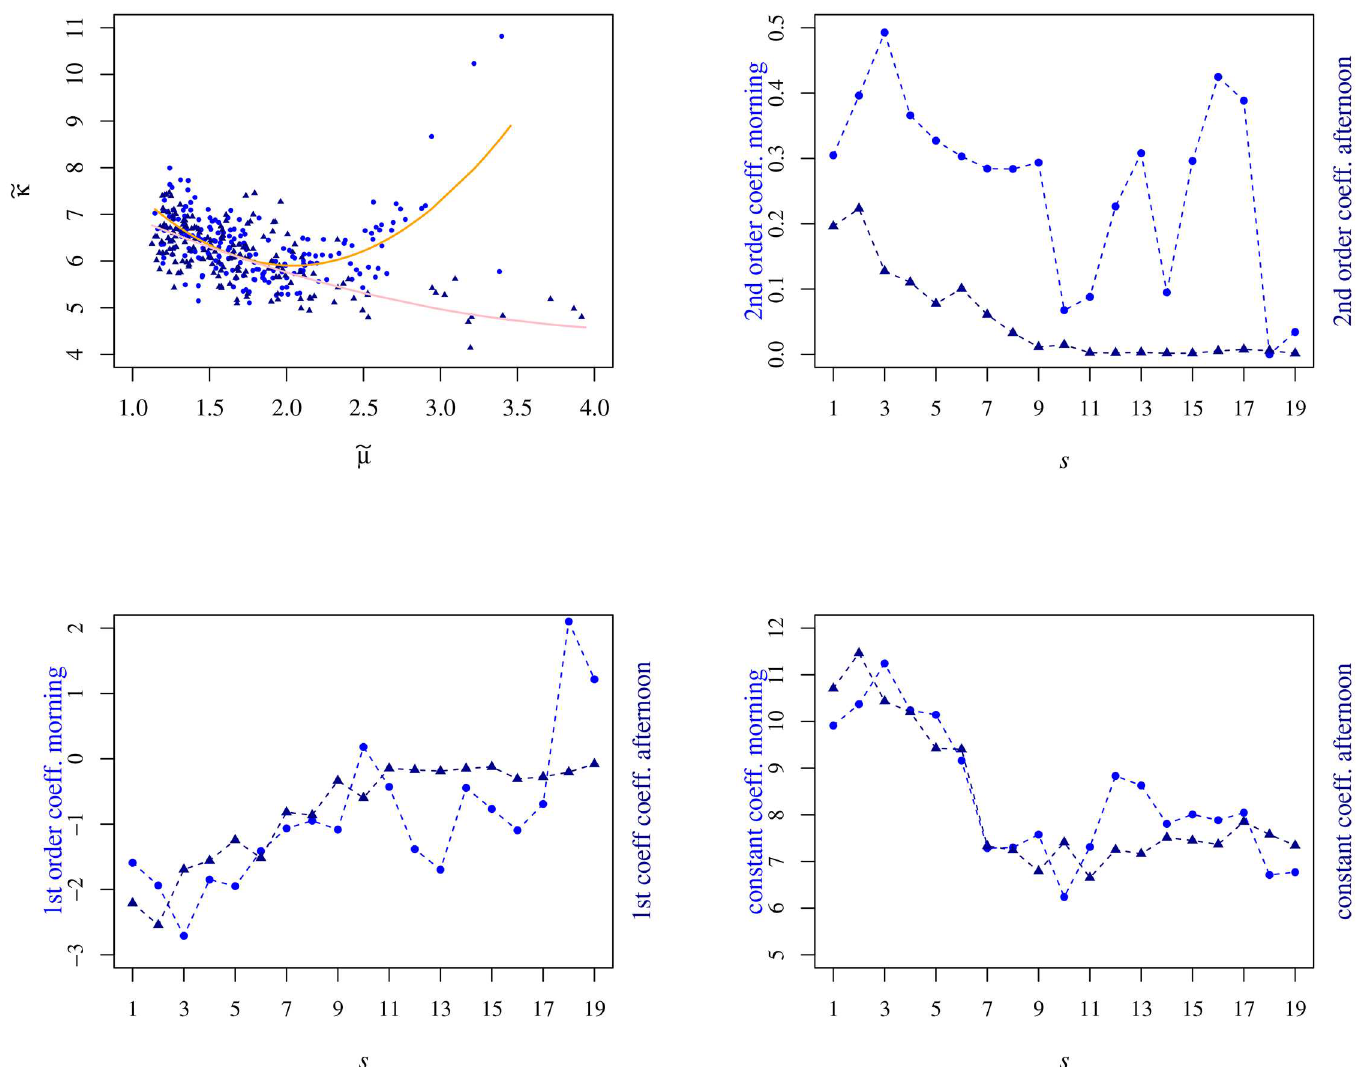
Fig 12. Relation between the kurtosis and the mean trading volume. In the upper left panel we present the scatter plot ~ k v ~ m for 1S06 where the lines correspondto the fits with a second order polynomial for each half of the trading session. For the morningorange line fit we have ~ k ¼ ð 1 : 5 (cid:6) 0 : 1 Þ ~ m 2 (cid:0) ð 6 : 1 (cid:6) 0 : 5 Þ ~ m þ ð 12 : 2 (cid:6) 0 : 5 Þ whereas for the afternoon pink line fit ~ k ¼ ð 0 : 19 (cid:6) 0 : 08 Þ ~ m 2 (cid:0) ð 1 : 8 (cid:6) 0 : 3 Þ ~ m þ ð 8 : 5 (cid:6) 0 : 4 Þ . The remaining panels present (in counterclockwise direction) the evolutionof the second, the first and the constant (order) polynomial